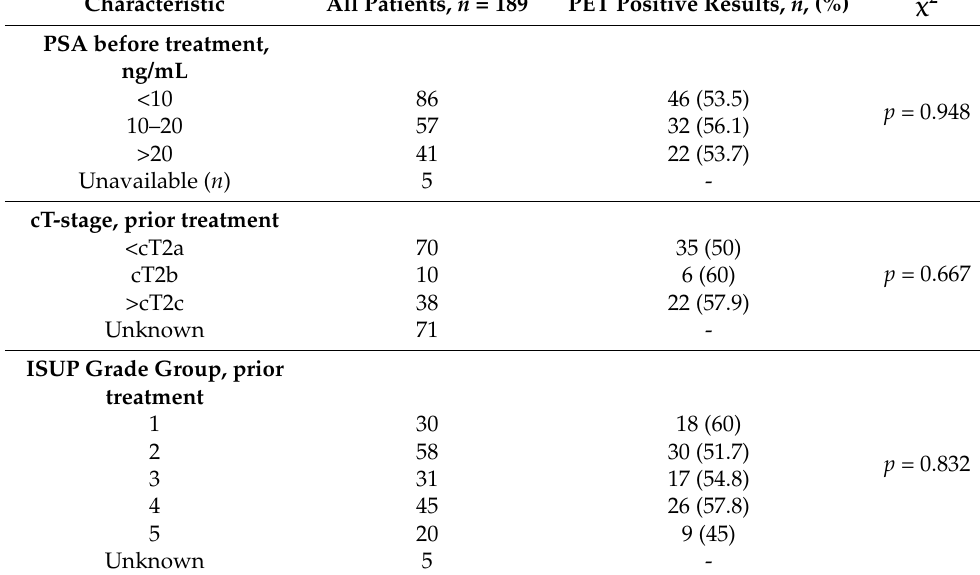
Table 2. Tumor characteristics during primary staging (All